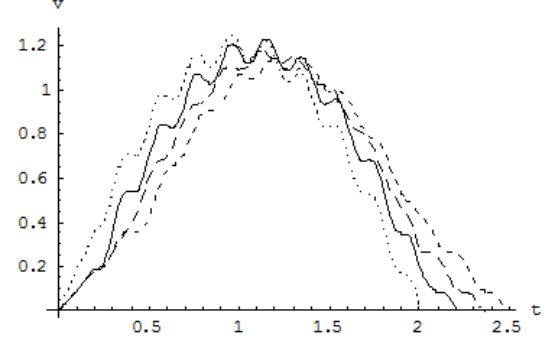
Figure 22: The influence of the vehicle length for R = 100 m, υ = 30 m/s, e H = 3.00 m, e V = 1.20 m and d = 3 m ( __ ), d = 5 m ( _ _ ), d = 7 m (- - - ) and d = 0 m ( .... ).